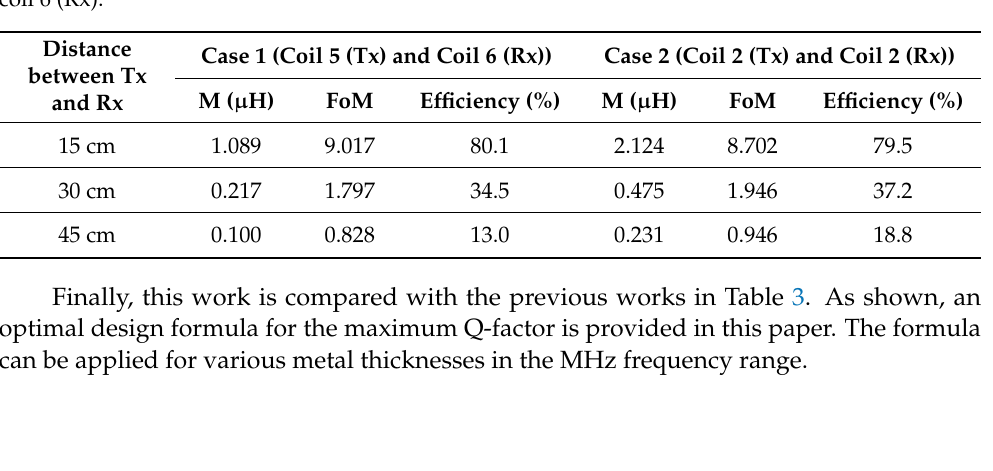
Table 2. Maximum coupling efficiency, mutual inductance, and FoM according to the distance between Tx and Rx coils for two cases. Case 1 is coil 5 (Tx) and coil 6 (Rx). Case 2 is coil 6 (Tx) and coil 6